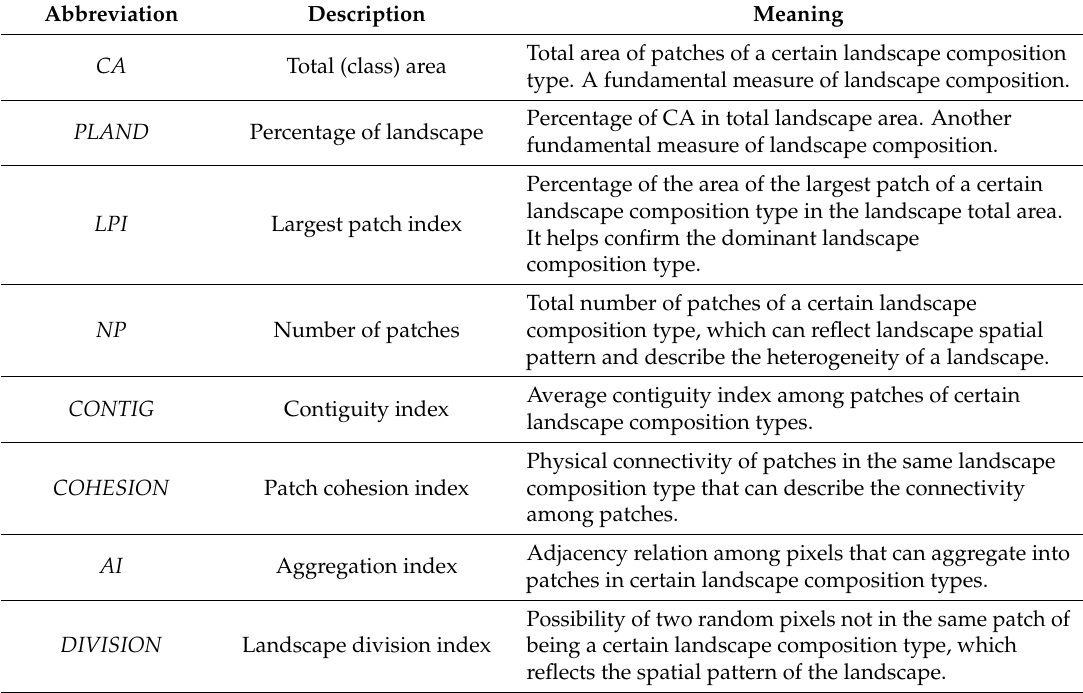
Table 1. Abbreviations, descriptions, and meanings of the selected landscape